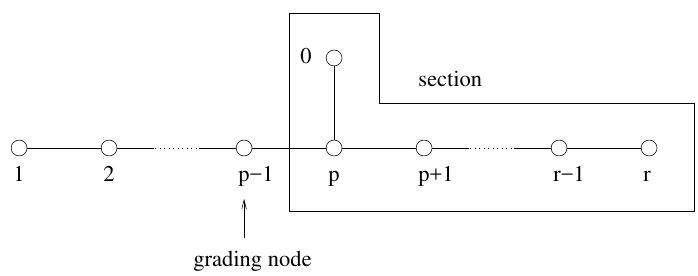
Figure 3 . The Dynkin diagram of A for g = A r , λ = Λ p , with the subdiagram corresponding to one of the two